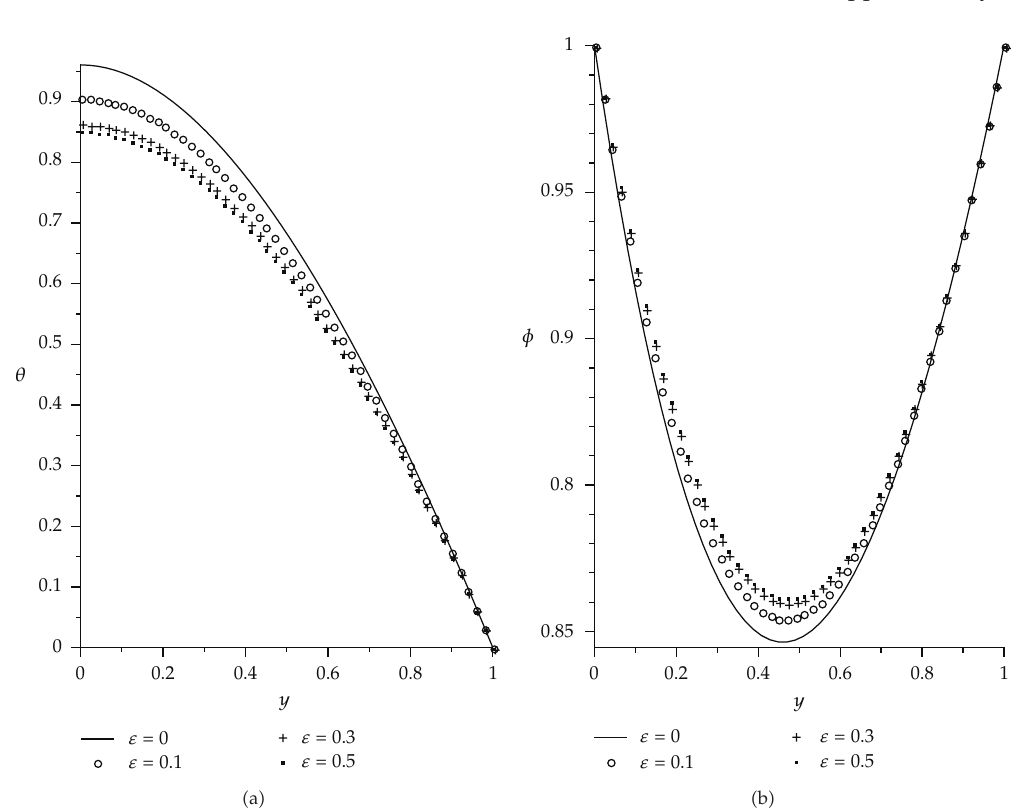
Figure 7: Temperature and oxygen concentration profiles for m (cid:8) 0 . 5 , n (cid:8) λ (cid:8) β (cid:8) 1 , θ w (cid:8)